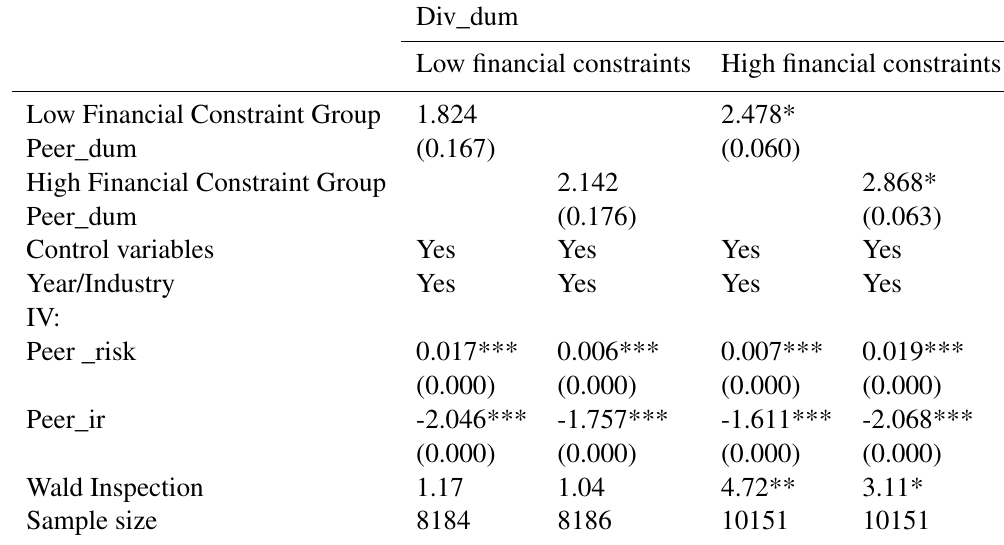
Table 8 Peer influence conduction path in different financial constrained